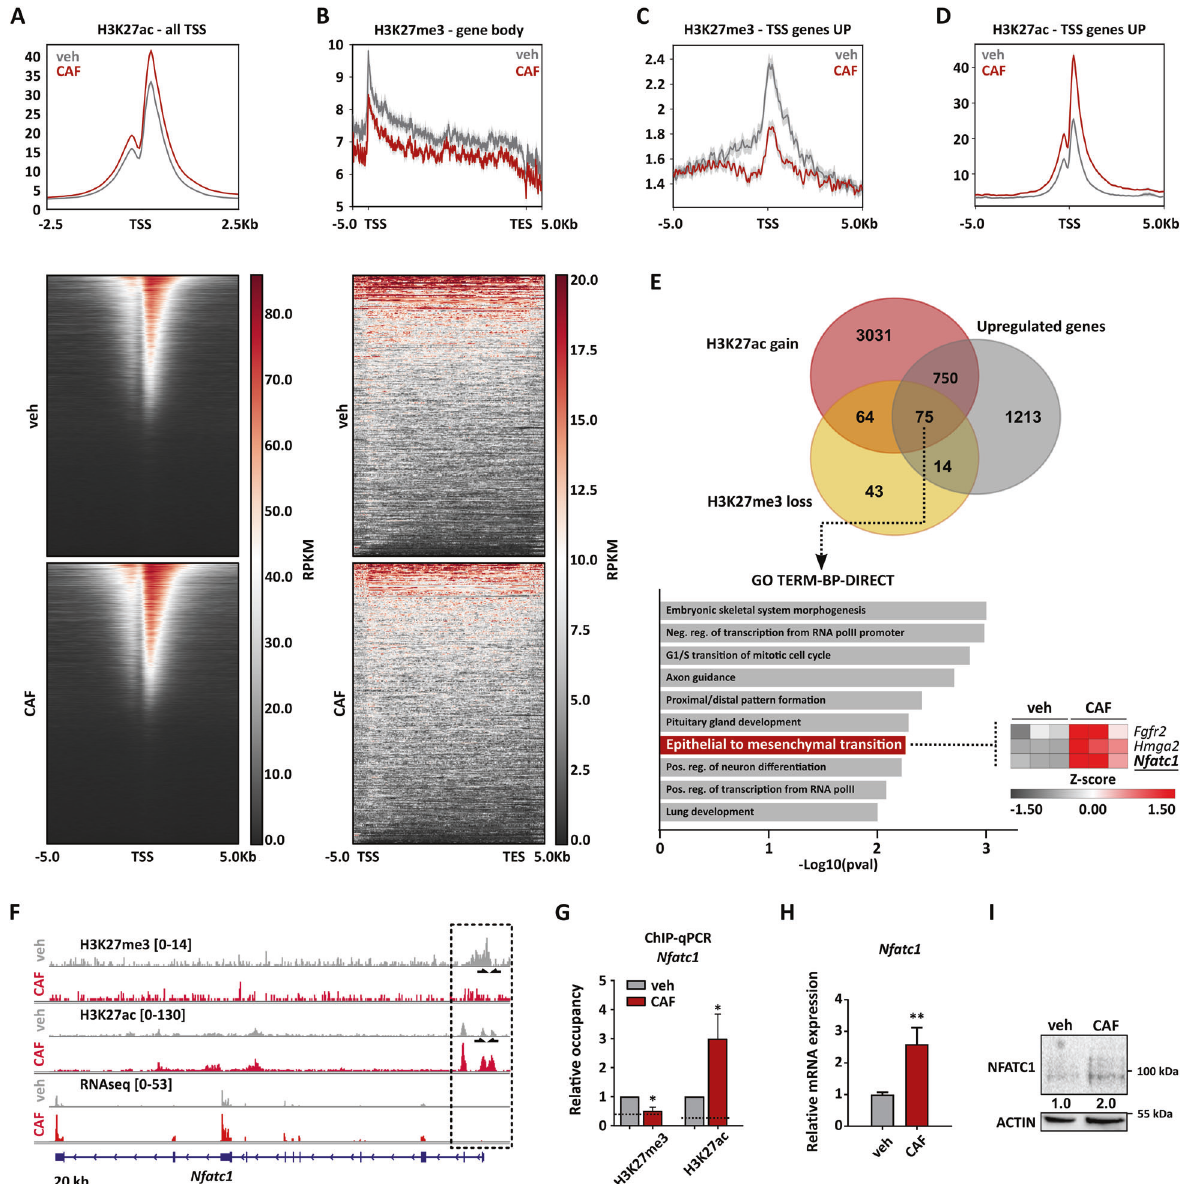
Fig. 4 Reduction of PRC2 activity during chemotherapy treatment allows activation of gene expression programs promoting tumor cell survival. A Global changes of H3K27ac at TSSs (±2.5 kb) upon CAF-treatment, visualized in an aggregate plot and heatmaps. B Global changes of H3K27me3 in gene bodies (±5 kb) of genes signi fi cantly marked under basal growth conditions, visualized in an aggregate plot and heatmaps. C and D Aggregate plots showing changes of H3K27me3 ( C ) and H3K27ac ( D ) occupancy at TSSs (±5 kb) of genes upregulated (log2FC > 0.8, p -val < 0.05) upon 48 h CAF-treatment. E : Identi fi cation of up-regulated genes showing a simultaneous loss of H3K27me3 levels and gain of H3K27ac occupancy upon CAF-treatment (upper panel). This group of genes was statistically signi fi cantly enriched, as assessed by Chi-square test. The 75 gene set was then used for signature enrichment analyses. Interestingly, regulators of the EMT program were identi fi ed in the Gene Ontology (GO) databases (DAVID web tool, (link: https://david.ncifcrf.gov/). F H3K27me3 and H3K27ac ChIP-seq tracks, and mRNA- seq tracks showing speci fi c occupancy changes upon CAF treatment at the Nfatc1 gene locus. The position of the primers used in the subsequent ChIP-qPCRs is provided by black arrows. G Validation of the epigenetic switch at the promoter region of Nfatc1 via ChIP-qPCR. The dashed line represents the background signal obtained with IgG control. H and I Changes of Nfatc1 expression upon CAF-treatment, as measured via qRT-PCR ( H ) and western blot ( I ). The densitometry values represent the normalized NFATc1/Actin signal. Error bars: Standard error of the mean (SEM). * p -val ≤ 0.05, ** p -val ≤ 0.01, *** p -val ≤ 0.005. Student ’ s t -test: G , H All experiments were performed in at least biological triplicates ( n = 3). we extracted the expression values of EZH2 and NFATc1 from with 119 different samples revealed that the majority of the tumor different publicly available human primary BC datasets and samples expressed moderate levels of EZH2 and high levels of observed a mild but signi fi cant anti-correlation (Fig. 5D, E). Survival NFATc1 (Fig. 5C left panel and Fig. S5G). Strikingly, an anti- correlation between EZH2 and NFATc1 levels was observed in ~2/3 of the samples (Fig. 5C, right panel). To further support our fi nding,